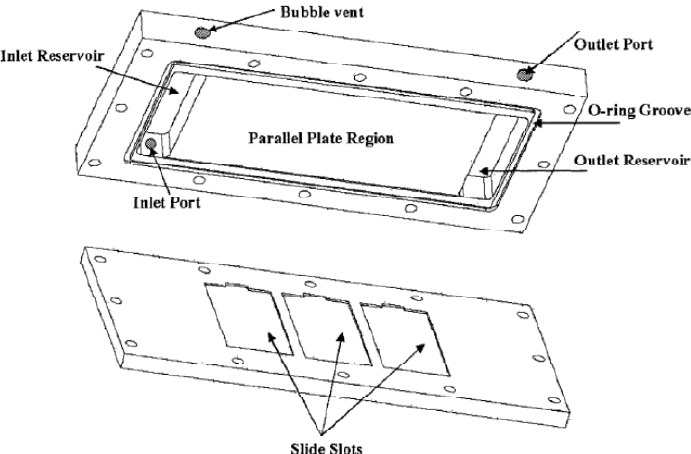
Figure 14. Schematic of flow chamber with inlet/outlet reservoirs. Reproduced from [58].